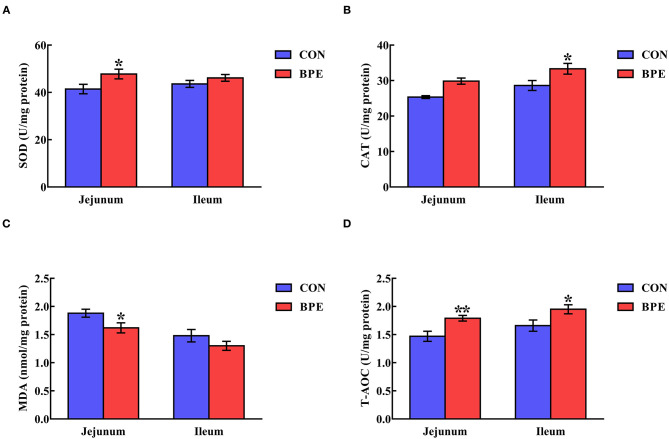
Effects of blueberry polyphenol extracts on the jejunal and ileal antioxidant status of weaned rats. (A) SOD, superoxide dismutase. (B) CAT, catalase. (C) MDA, malondialdehyde. (D) T-AOC, total antioxidant capacity. Values are means with standard errors represented by vertical bars. *P < 0.05 or **P < 0.01.